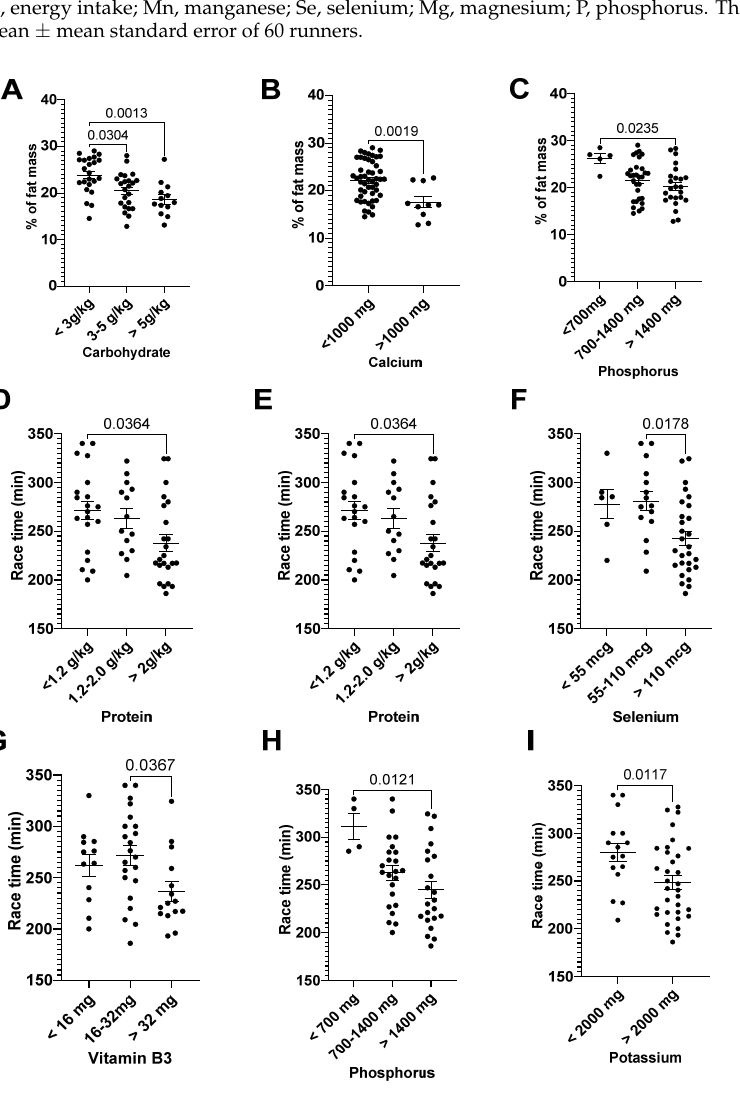
Figure 1 . General characteristic and dietary intake. Percentages of fat mass and carbohydrate ( A ), calcium ( B ), and phosphorus ( C ) intake; race time and protein ( D ), cholesterol ( E ), selenium ( F ), vitamin B3 ( G ), phosphorus ( H ), and potassium ( I ) intake. The percentages of fat mass and race time were presented as mean ± EPM, as well as individuals’ values.